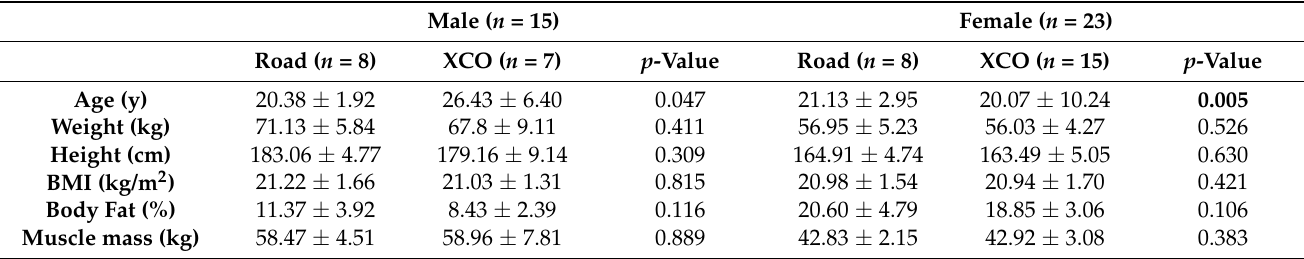
Table 1. General characteristics of